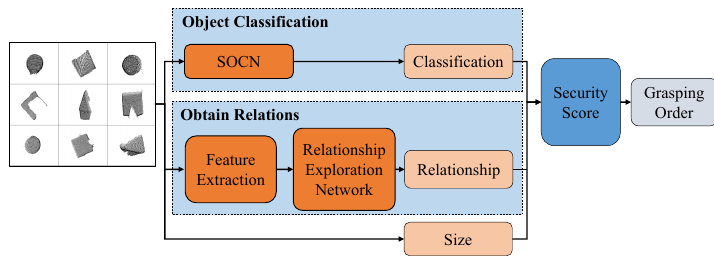
Figure 1. Architecture of the proposed robot grasping